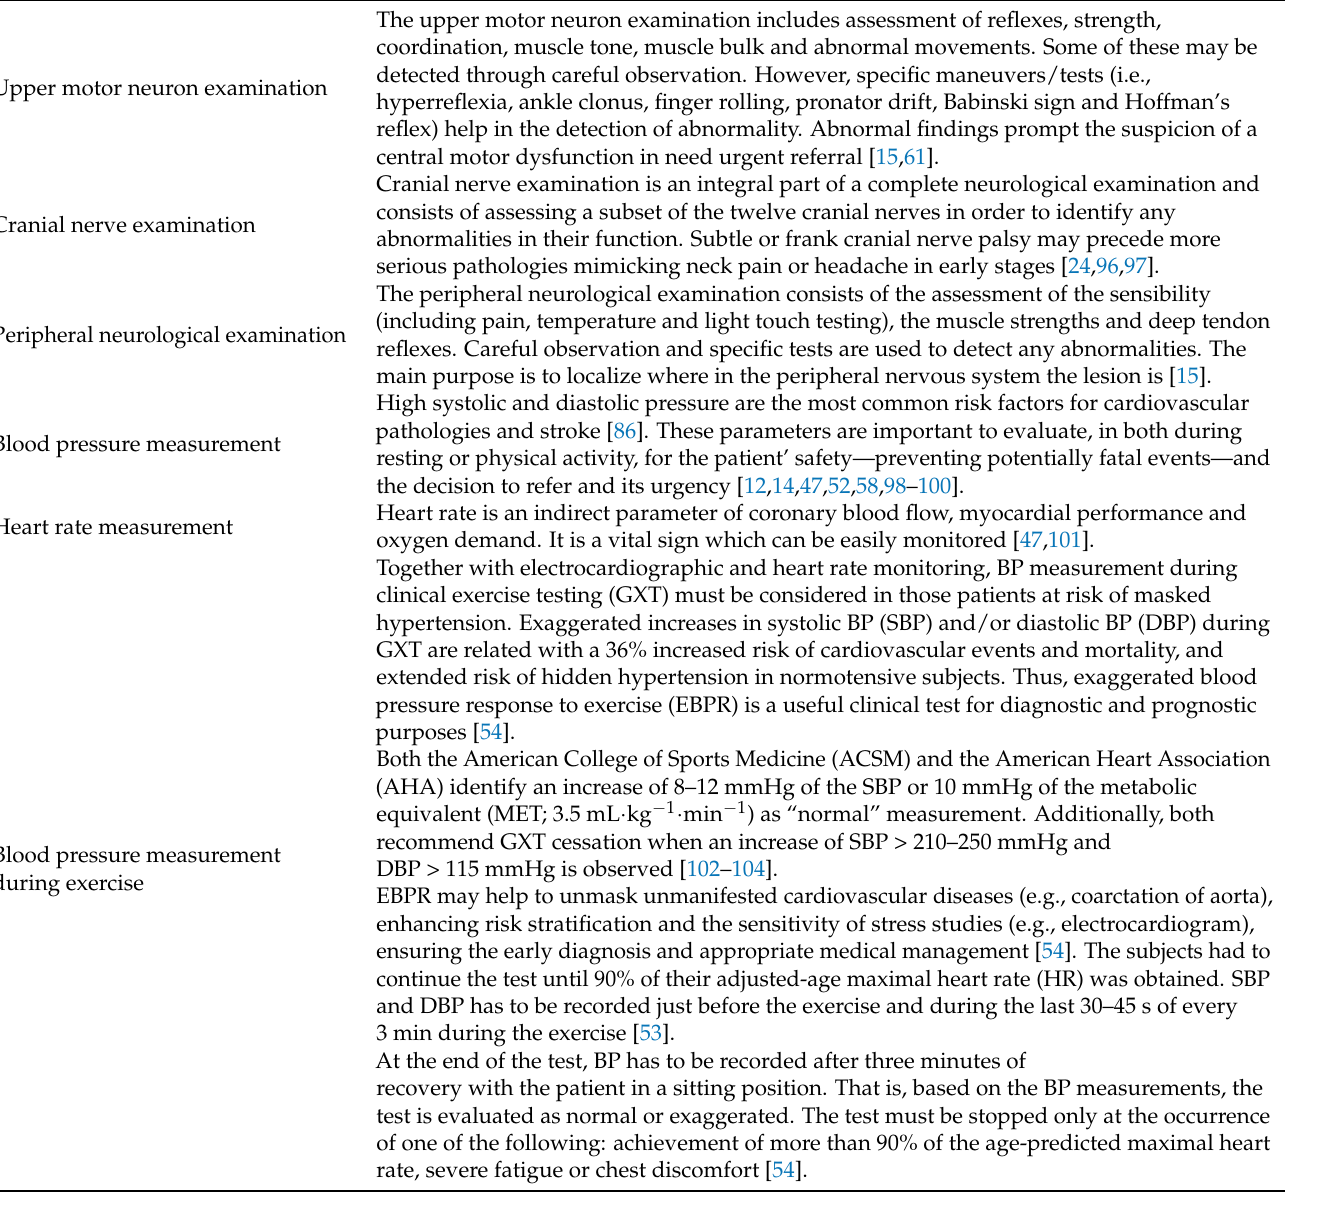
Table 3. Core skill set testing for the physiotherapy screening for referral.